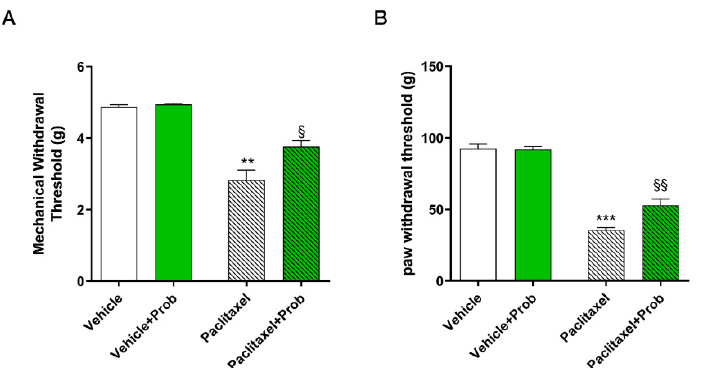
Figure 3. Behavioral tests: ( A ) Von Frey test to evaluate mechanical allodynia ( B ) Randall-Selitto to evaluate mechanical hyperalgesia. ***, p < 0.0001; **, p < 0.005; vs. vehicle; §§, p < 0.005; §, p < 0.05 test to evaluate mechanical hyperalgesia. ***, p < 0.0001; **, p < 0.005; vs vehicle; §§, p < 0.005; §, p < vs. paclitaxel ( n = 0.05 vs paclitaxel ( n = 10).